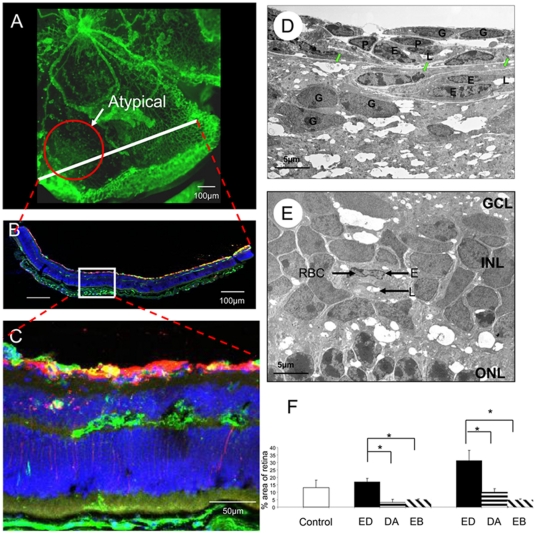
Epoetin delta modulates intra-retinal neovascularisation.The retina in Epoetin delta-treated mice often demonstrated lectin-stained “atypical vessels” (A). This is a dismounted flatmount imaged immediately prior to cryobedding. A representative of the serial sections of the flat-mounts is illustrated in Fig. (B). The area within the white box of Fig. 7B is more clearly illustrated in Fig. 7B Here it is clear that the “atypical vessels” are located inside the retina with lectin stained green and GFAP red (C). Using electron microscopy it is evident that the neovascular tissue and glial cells were on both sides of the internal limiting membrane (green arrows) (D). The pre-retinal vessels often had pericyte covering (P) and multiple glial associations (G) although both intra- and preretinal vessels had well-formed lumens (L). In the middle of the ischaemic regions there were exclusively intra-retinal vessels in the nerve fibre layer and sometimes between the Inner nuclear layer (INL) and outer nuclear layer (ONL) that were perfused with red blood cells in the lumen (RBC) (E). Epoetin delta treatment at high dose significantly increased “atypical”, intra-retinal vascularisation in OIR (*p<0.05) (F). Low dose displayed no difference in the “atypical”, intra-retinal vascularisation of the entire retina. Darbepoetin Alfa and Epoetin Beta reduced the intra-retinal vascularisation of the retina (p<0.05) (n = 7). (Error bars  =  Standard Error of the Mean).